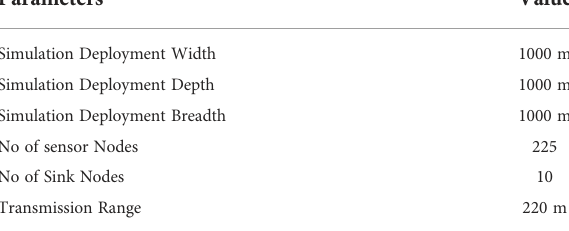
TABLE 1 Simulation parameters.